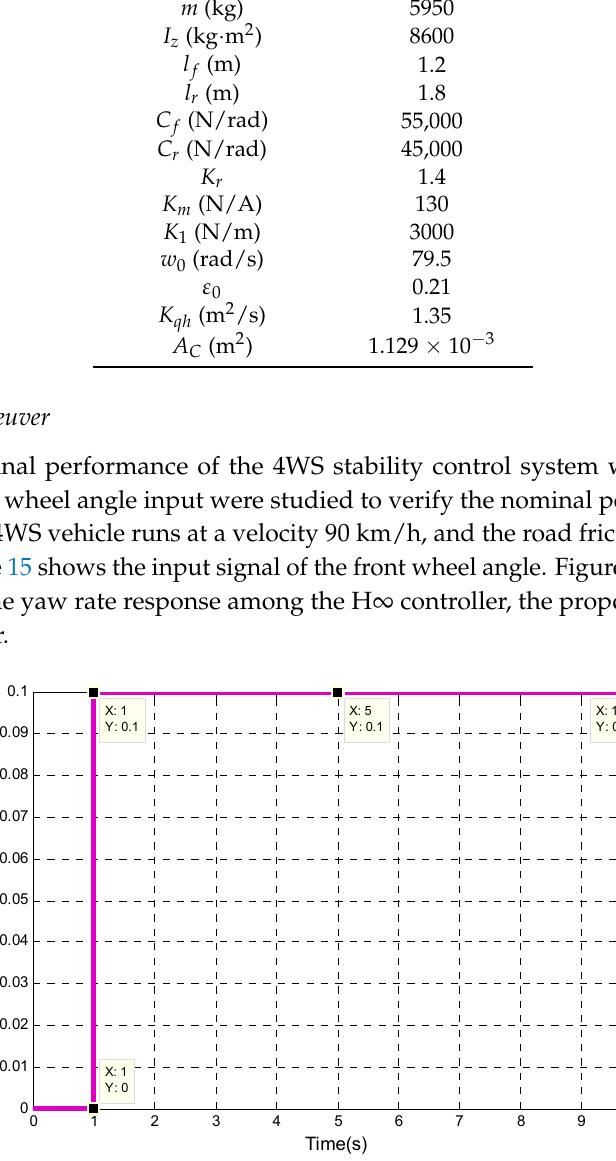
(b) Figure 16. The step responses of the front wheel angle: ( a ) sideslip angle response; ( b ) yaw rate response. As can be seen in Figure 16a, the sideslip angle with the proportional controller had large overshoot, and the sideslip angle with the H ∞ controller presented certain fluctuations. Compared